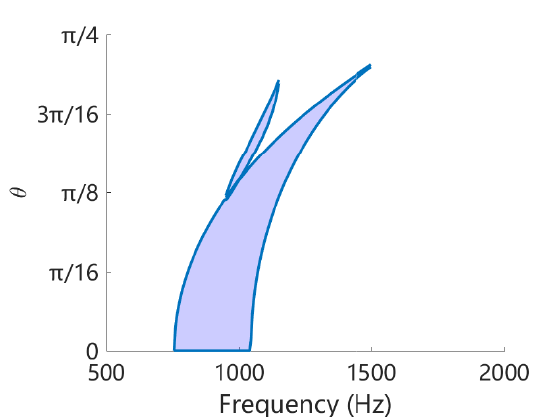
Figure 13. Variation of the angular width of band gaps with respect to the frequency, for L-network with L = 0.2 H.